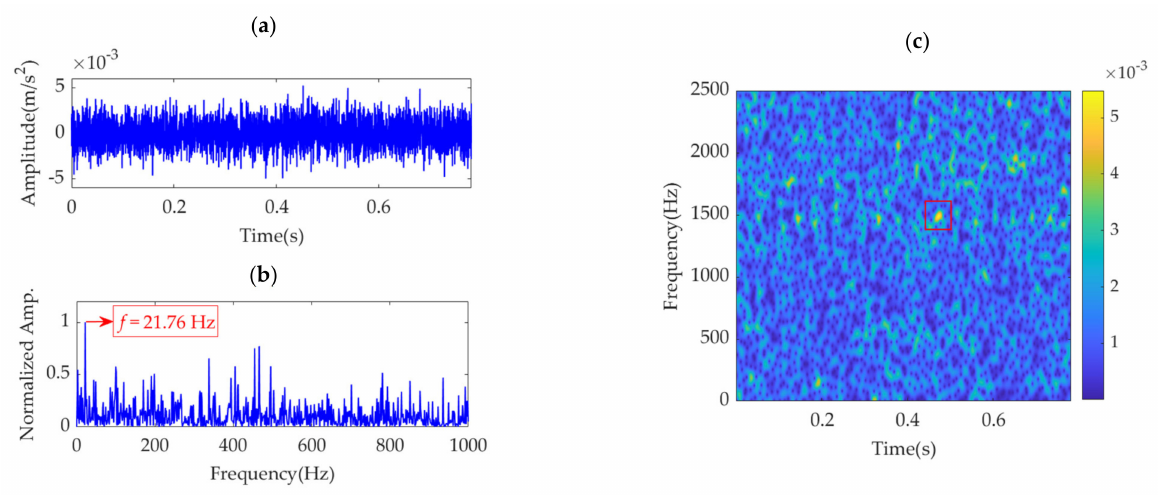
Figure 14. Vibration dataset with additional noise: ( a ) time–domain waveform, ( b ) SES, and ( c ) STFT spectrum.